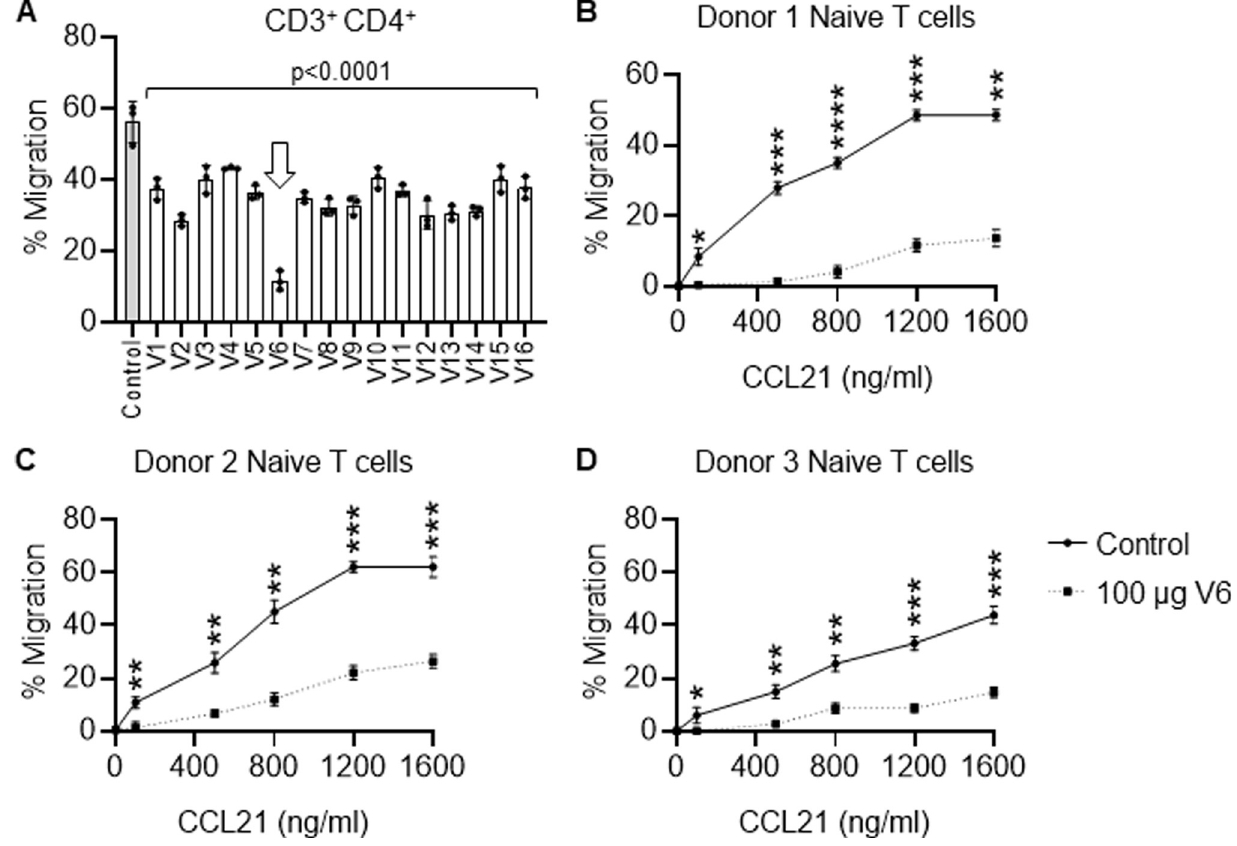
Fig 6. Screening of fully humanized anti-CCL21 monoclonal antibody clones derived from clone C8. (A) Inhibition of migration in transwell chemotaxis assays of helper T cells (CD3 + /CD4 + ) towards 1200 ng/ml rhCCL21 by the 16 humanized clones, referred to as V1 to V16, used at 100 μ g/ml. All versions of humanized clones tested inhibited T cell migration towards CCL21 to some degree. However, V6 was the most potent at inhibiting T cell migration towards CCL21 (arrow). Data are the mean ± SD of triplicate wells. One-way ANOVA with post-hoc Tukey’s multiple comparison tests were performed for statistical analysis. All groups had a p < 0.0001 when compared to control. (B-D) Confirmation of V6 inhibition of CD3 + /CD4 + /CD8 - / CCR7 + /CD45RA + /CD27 + Na ï ve Th-cell chemotaxis towards 100, 500, 800, 1200, and 1600 ng/ml rhCCL21 using CD3 + peripheral blood na ï ve Th-cells from 3 normal human donors. Data are the mean ± SD of triplicate